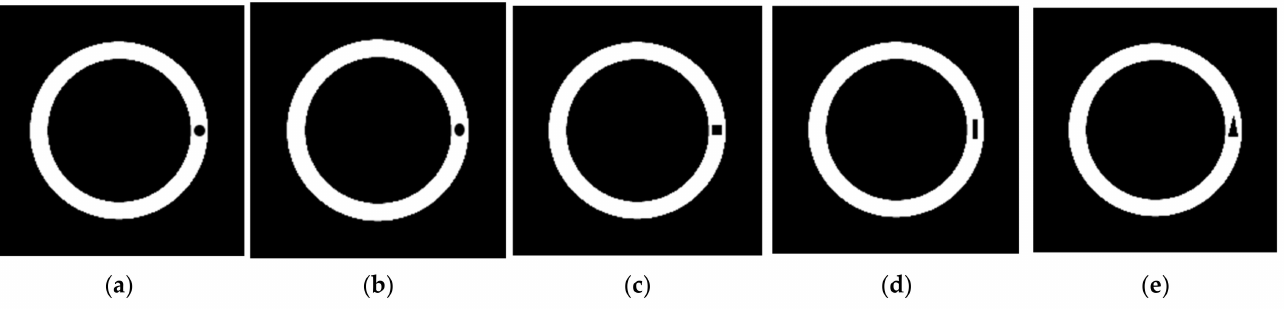
Figure 5. Modified CT images for different shapes of simulated microchannels with a cross-sectional area of 64 pixel 2 (0.2273 mm 2 ). ( a – e ): circular, oval, square, rectangular,